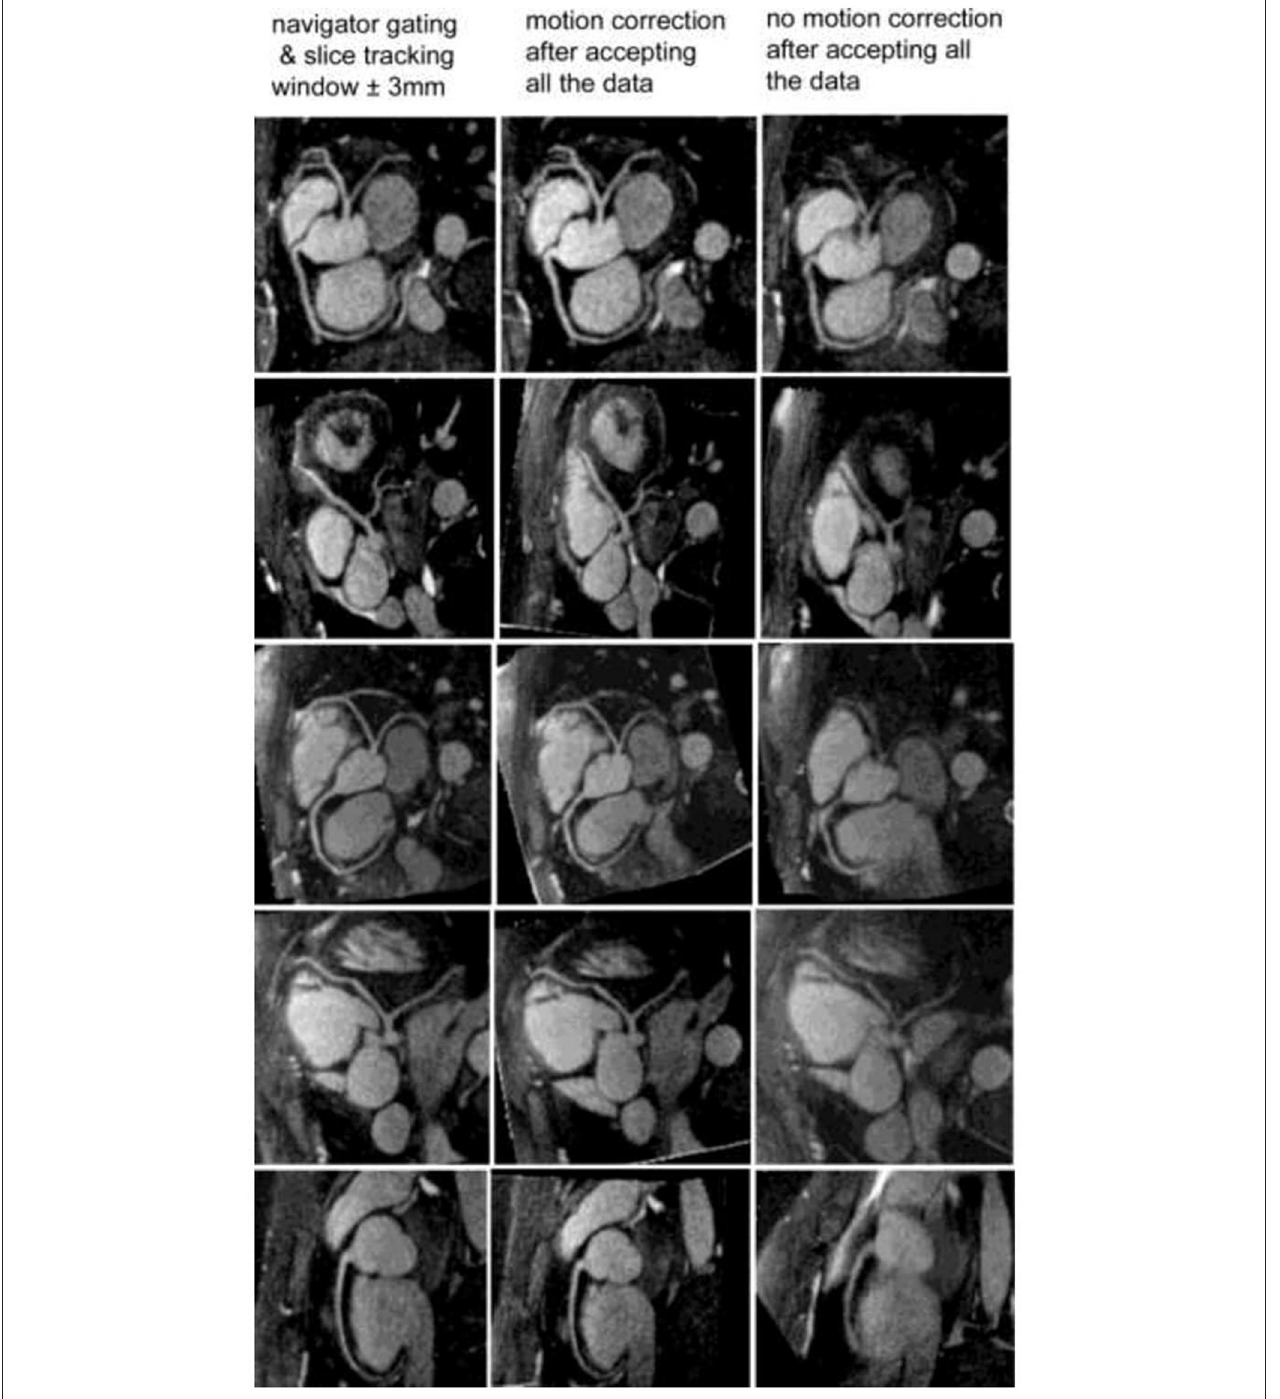
FIGURE 3 | Reformatted coronary artery images from five healthy volunteers. With the motion correction technique (middle column), coronary artery visualization is excellent and similar to the navigator gating and slice tracking approach (left column). Without any motion correction (right column), the images are blurry and the coronary artery visualization is poor. The imaging time with the motion correction technique is reduced by a factor of 2.5 to 3 compared with the navigator gating and slice tracking approach. Adapted with permission from Bhat et al. (53).